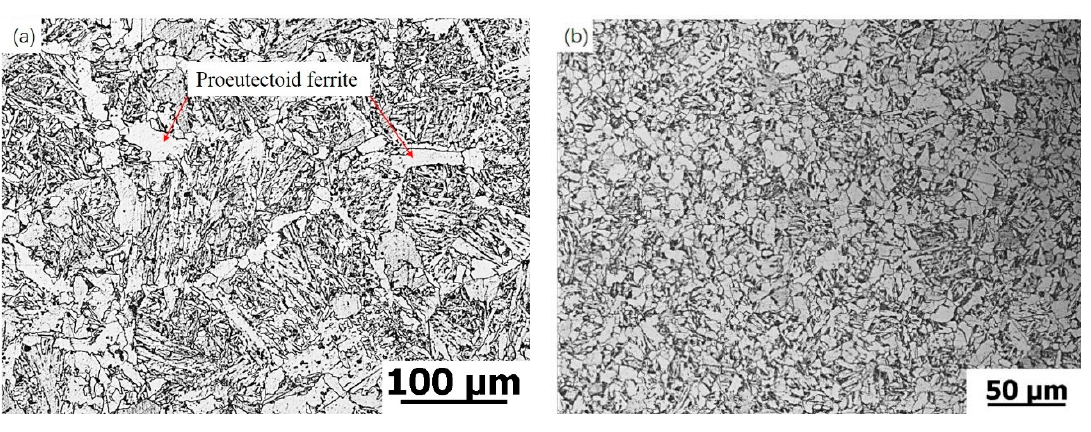
Figure 1. Heat-affected zone (HAZ) microstructure of testing steel: ( a ) without Mo; and ( b ) with Mo.